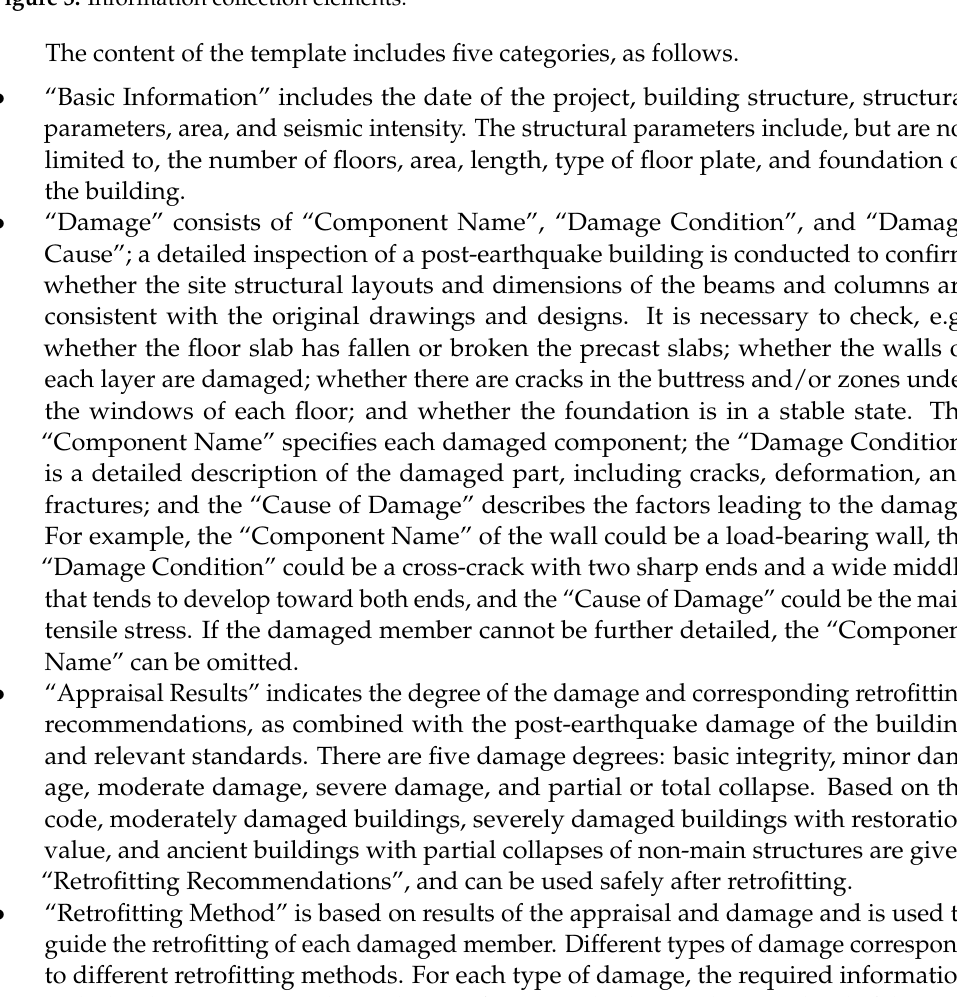
Figure 3. Information collection